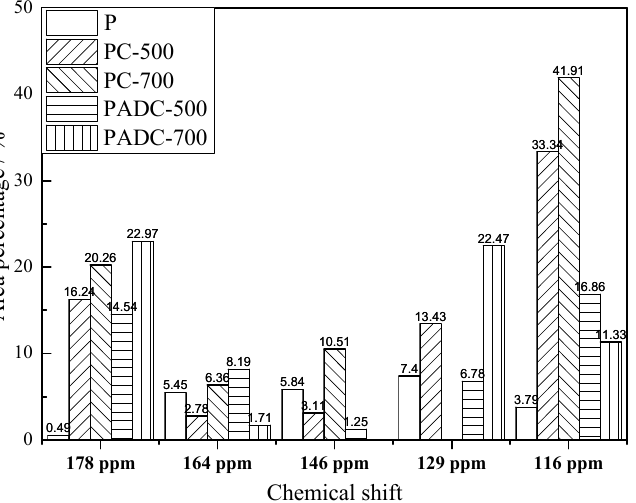
Figure 6. Variation of the aromatic carbon structure area percentage assigned at chemical shift.